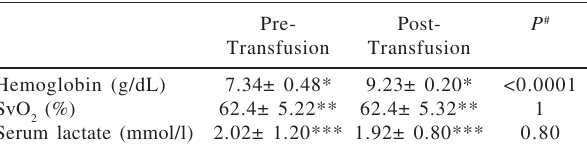
venous oxygen saturation